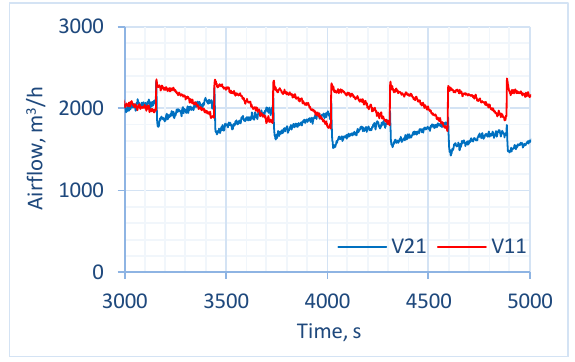
Fig. 2. Fresh V 21 and exhaust V 11 air volume flow rates.